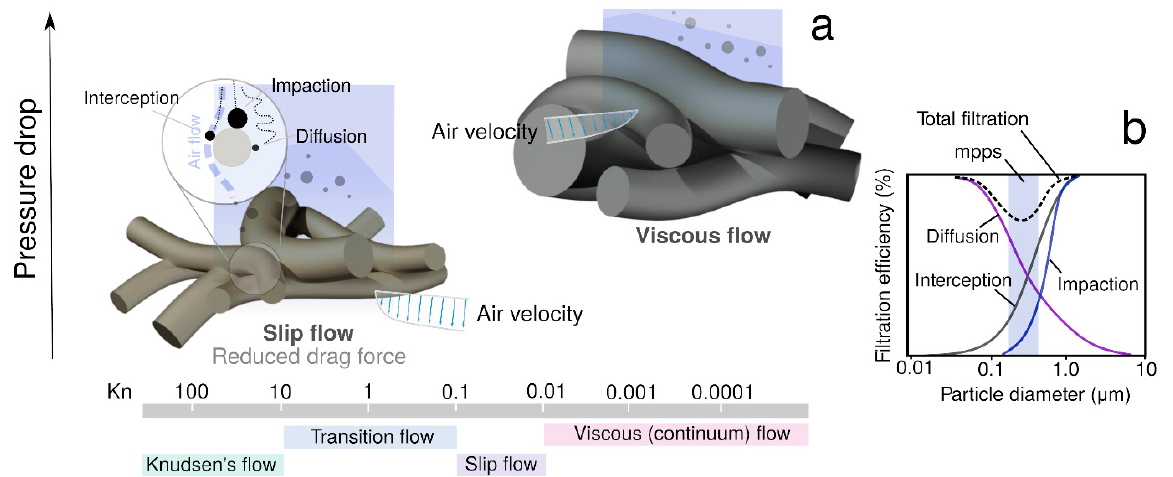
Figure 2. Classification of flow regimes with Knudsen number: ( a ) comparison of the flow regimes with different fiber diameters; ( b ) dependency of the filtration mechanism on the particle diameter.